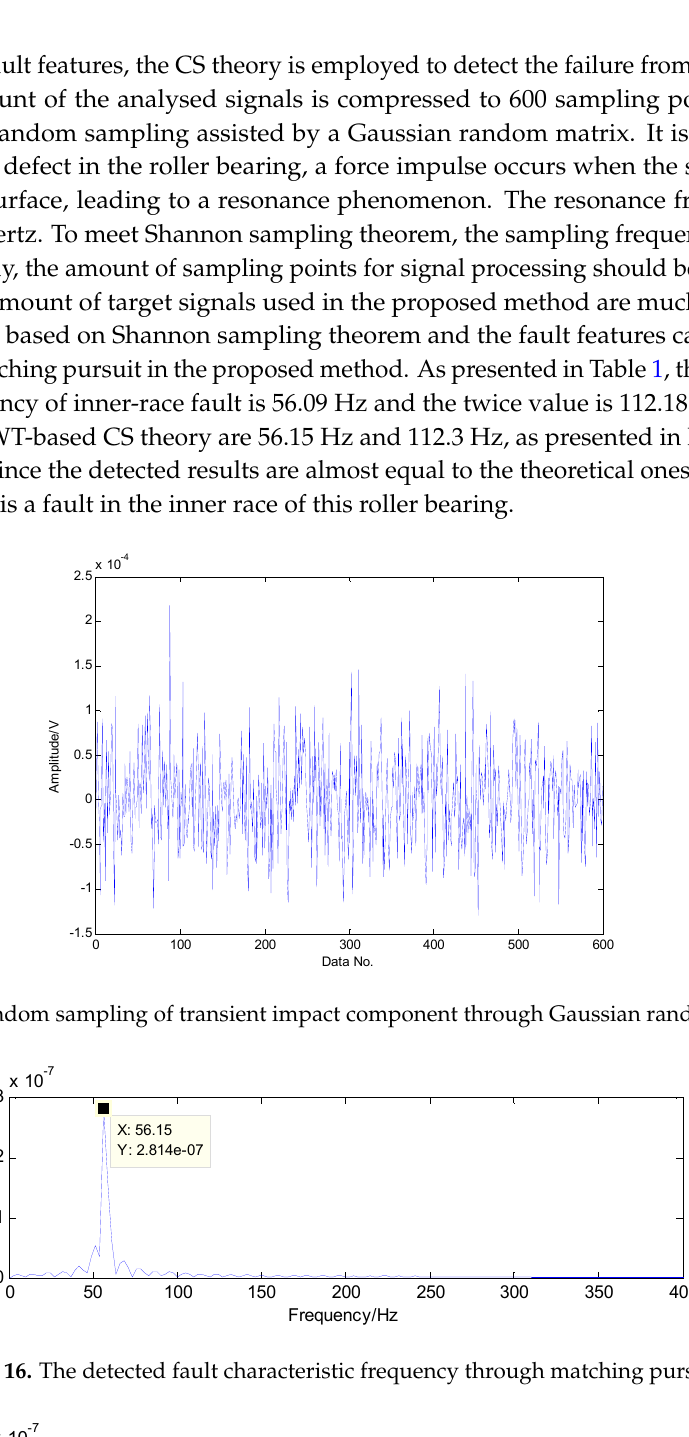
Figure 14. Envelope spectrum of the transient impact component in Figure 11.